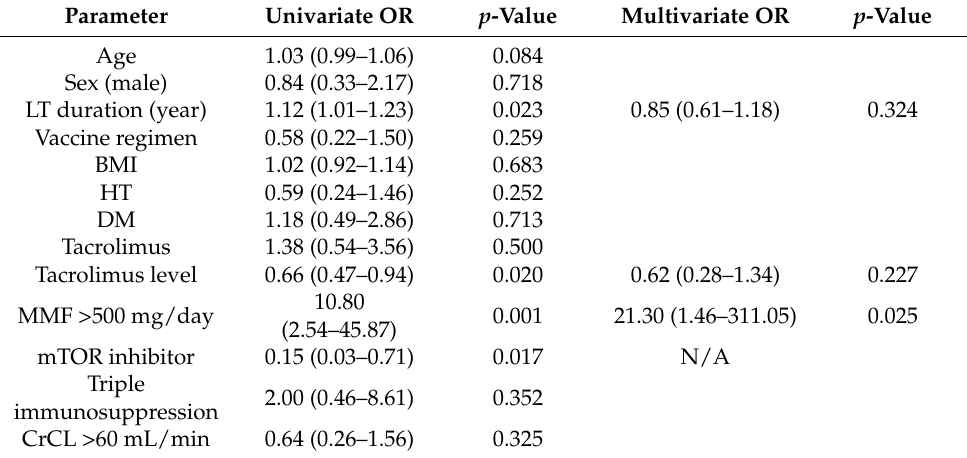
Figure 2. Dynamic of anti-SARS-CoV-2 binding-receptor-domain antibody (anti-RBD) after the primary vaccination and the booster vaccine in LT recipients among LT recipients (*, statistically significant; NS, non-statistically significant). Table 3. Predictors of poor humoral immune response after primary vaccination in LT recipients